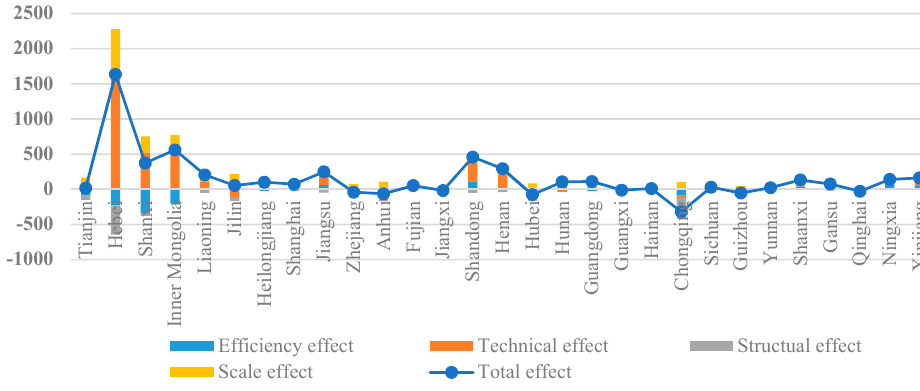
Figure 7. Structural decomposition of input embodied carbon during the period of 2002–2007 (ten thousand tons).